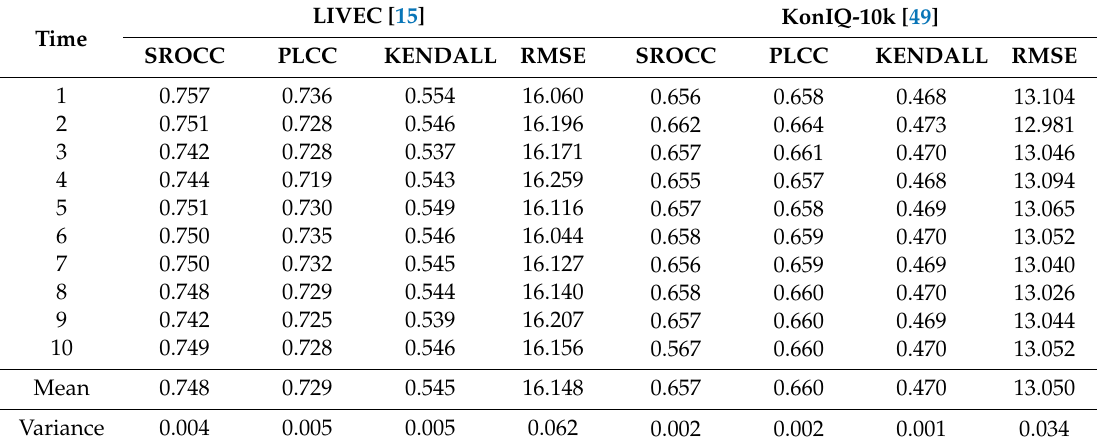
Table 4. Detailed data for 10 tests on the Base